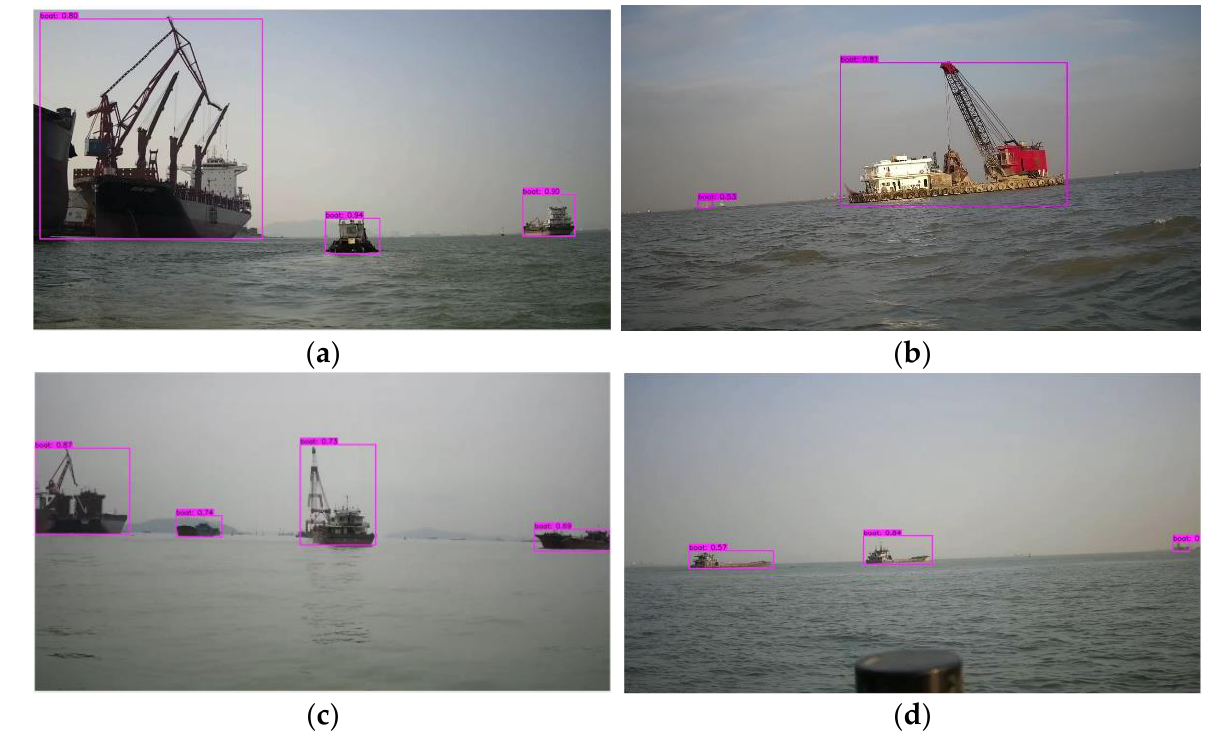
Figure 6. Target detection results of multiple ships with large difference in ship size in actual scenes. ( a ) Small ships next to the large ship. ( b ) Remote small ship detection. ( c ) Large ships and small ships are intertwined. ( d ) Multiple distant ship target